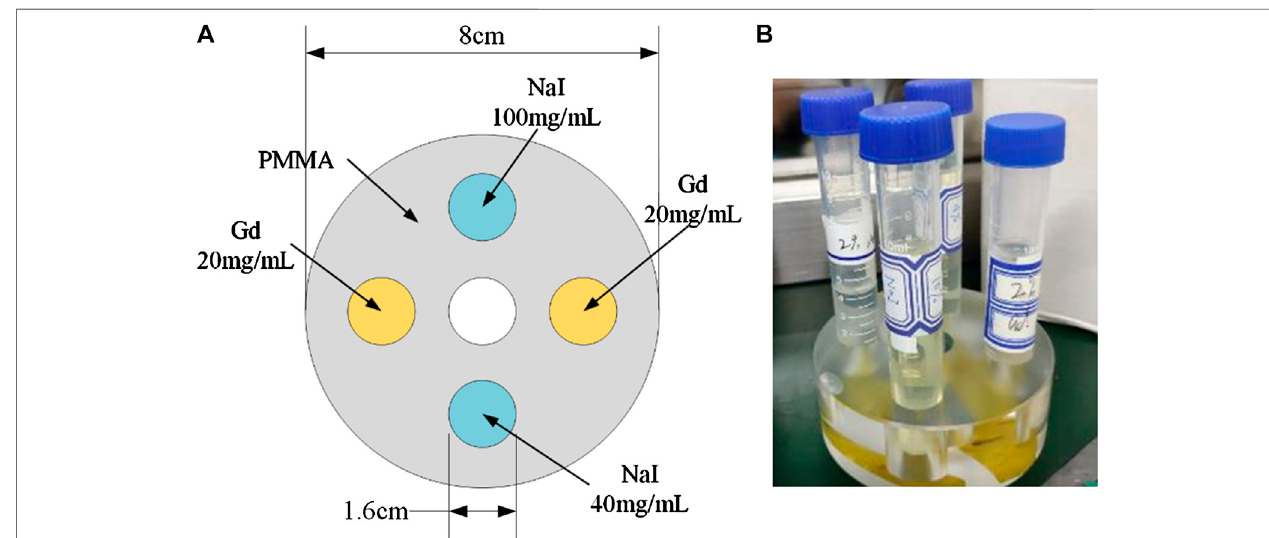
FIGURE 8 | Phantom used in the experiment: (A) schematic diagram; (B) physical diagram.